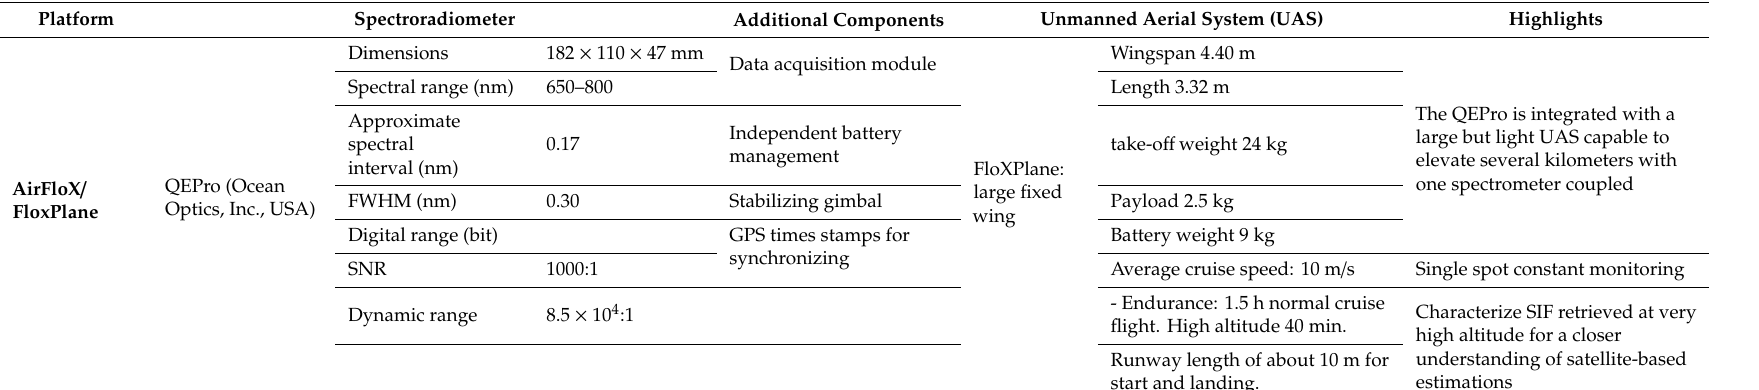
Characterize SIF retrieved at very high altitude for a closer understanding of satellite-based estimationsRunway length of about 10 m for